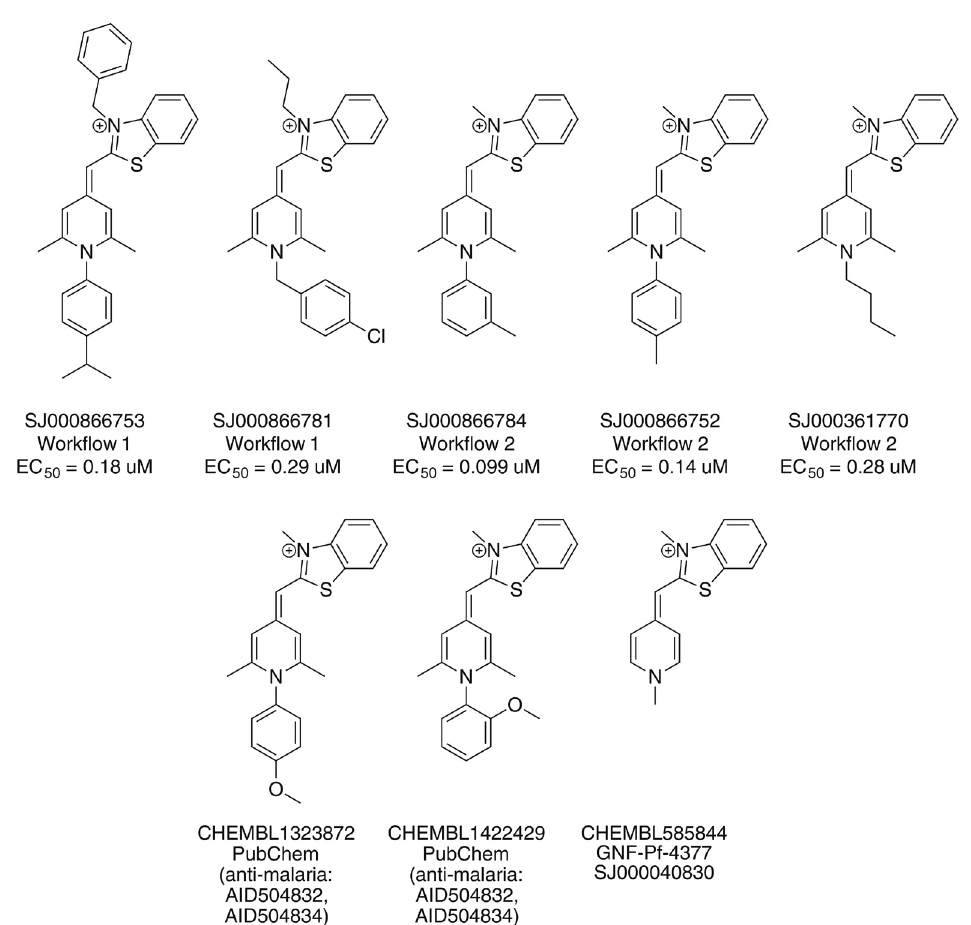
Figure 6. Compounds with a benzothiazole scaffold. (Top): Compounds predicted by Workflow 1 and Workflow 2. (Bottom): Compounds that are actives from PubChem, Novartis-GNF Malaria Box 40 and St. Jude Children’s Research Hospital 24 .